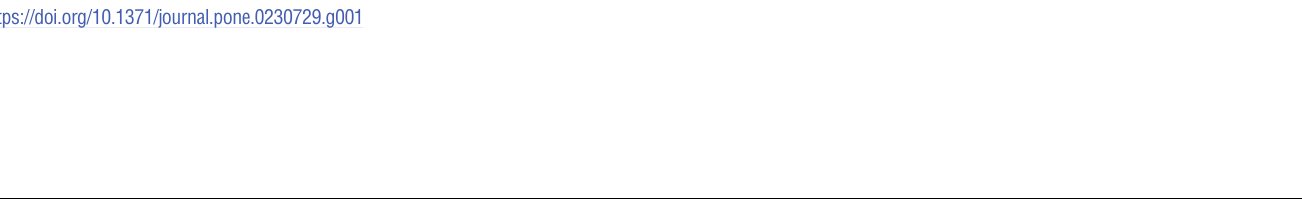
PLOS ONE | https://doi.org/10.1371/journal.pone.0230729 April 1, 2020 4 /